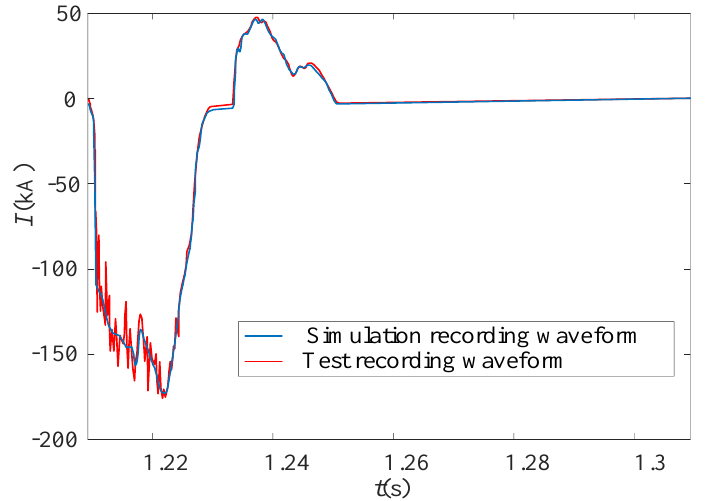
Figure 19. The current waveforms of field-test and simulation.